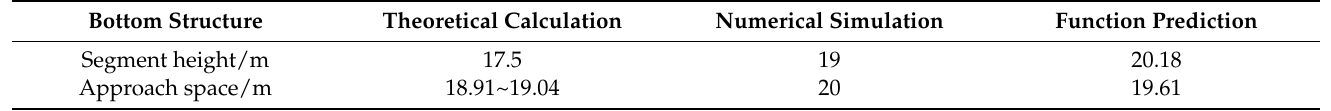
Table 4. Statistical table of the range of structural parameters obtained by each method. Bottom Structure Theoretical Calculation Numerical